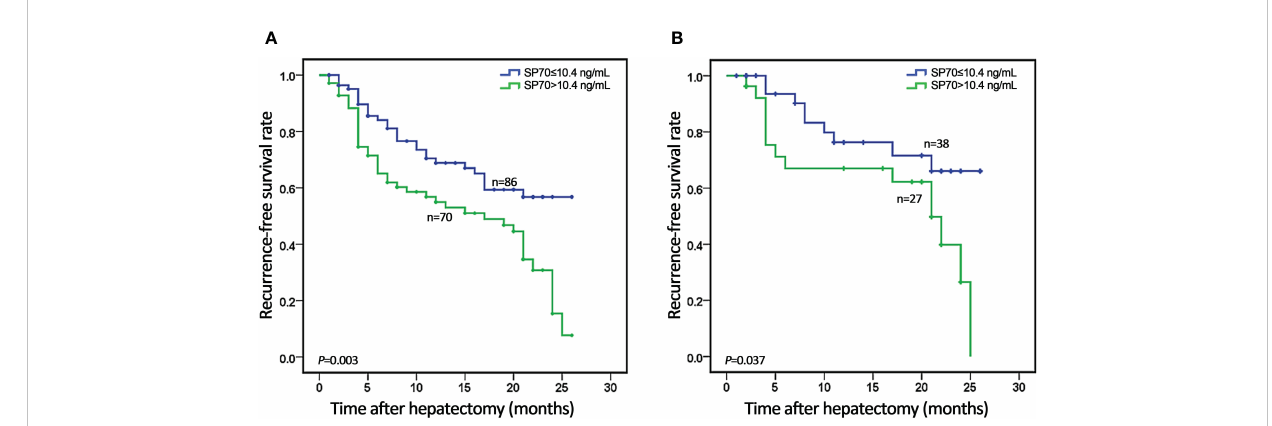
FIGURE 4 Kaplan – Meier analysis of recurrence-free survival (RFS) strati fi ed by serum SP70 level. (A) Association of SP70 level with RFS in all 156 HCC patients; (B) Association of SP70 level with RFS in the AFP-negative subgroup.